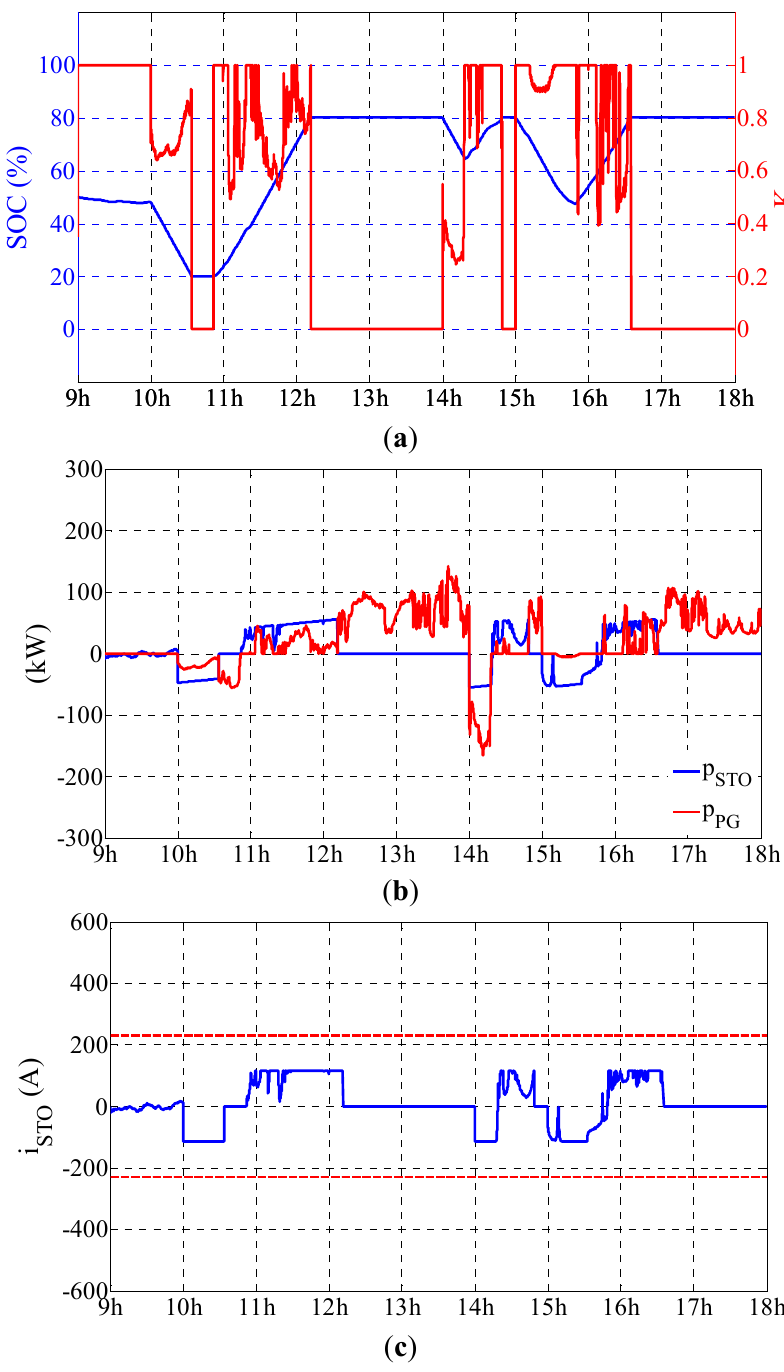
Figure 11. Storage current limitation case: ( a ) Storage SOC and distribution coefficient K ; ( b ) Power evolutions of storage and public grid; ( c ) Storage current